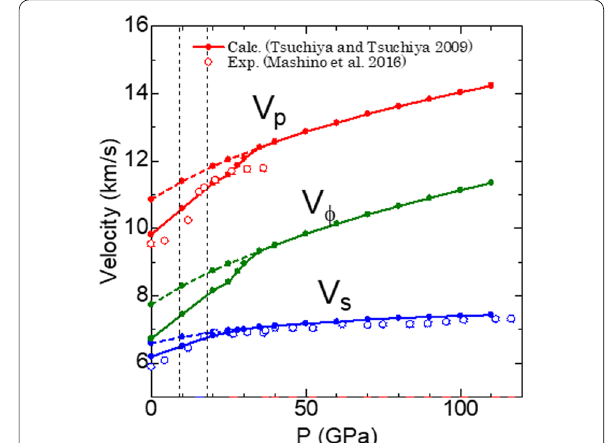
Fig. 7 The calculated and experimental velocities (Tsuchiya and Tsuchiya 2009; Mashino et al. 2016) of δ -AlOOH. Dashed lines indicate the pressure conditions where symmetry change (9 GPa) and hydrogen bond symmetrization (18 GPa) were observed experimentally (Sano-Furukawa et al. 2008,